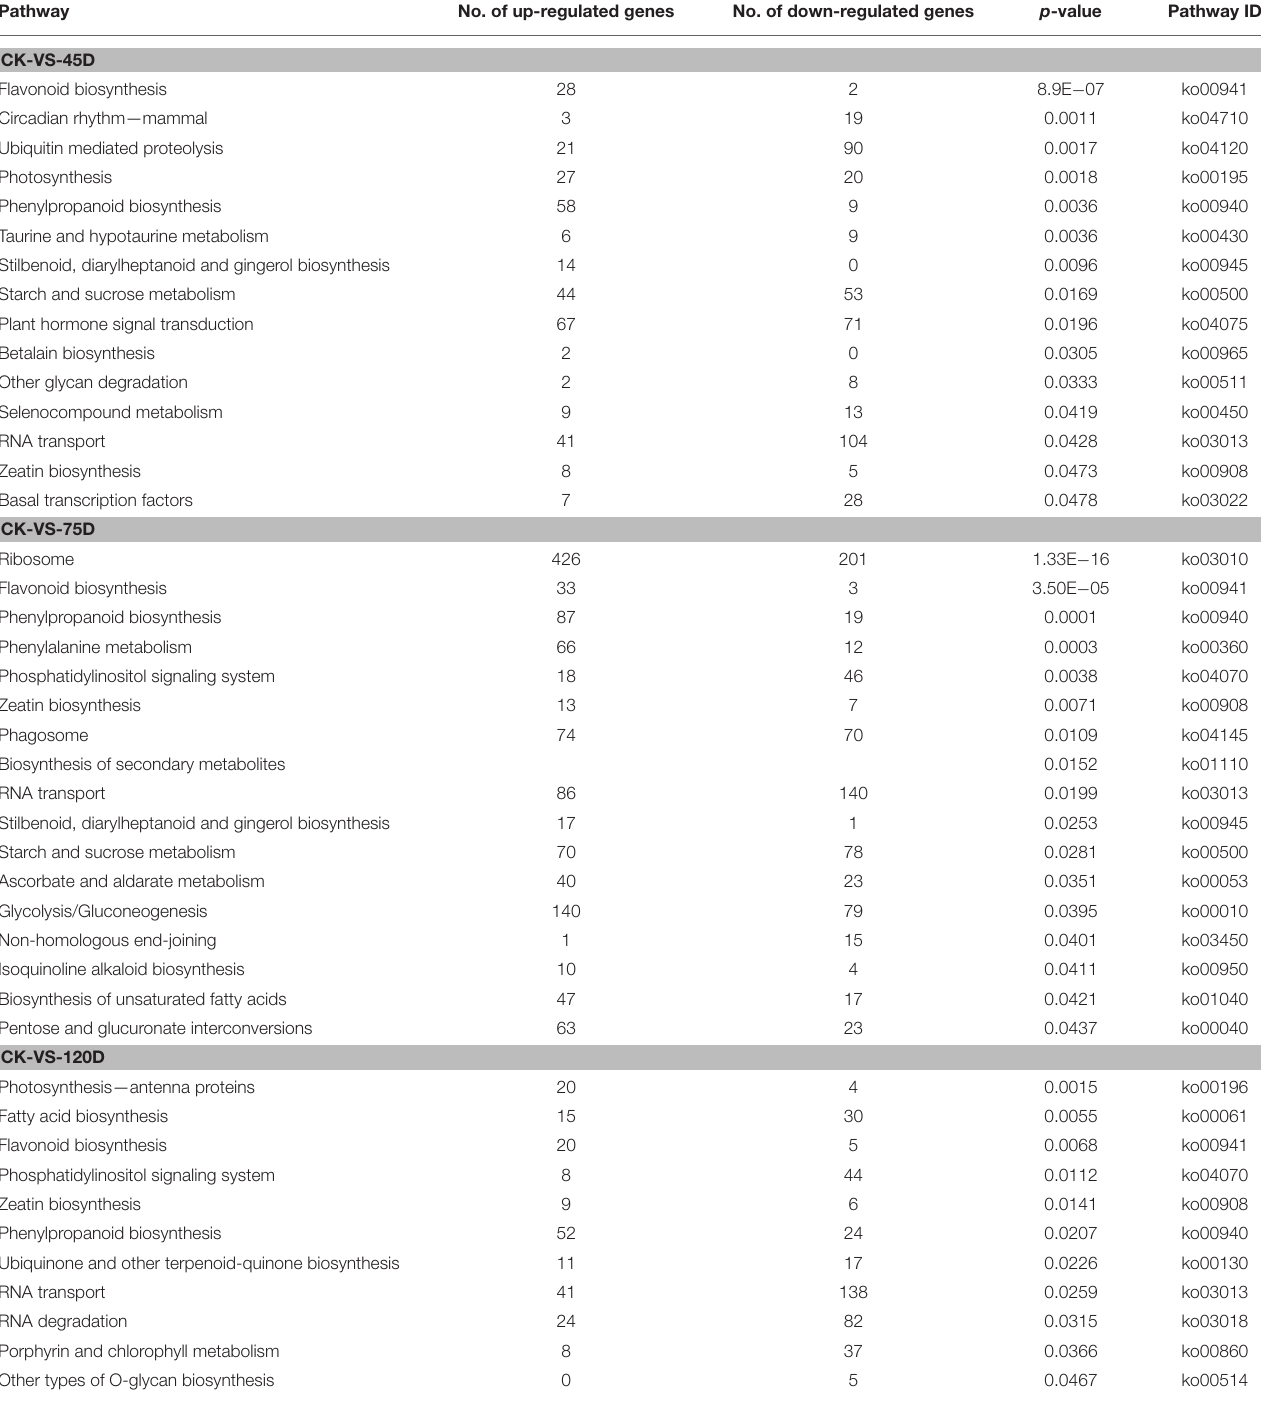
TABLE 2 | Significantly enriched KEGG pathways of DEGs by F. mangiferae infection. Pathway No. of up-regulated genes No. of down-regulated genes p -value Pathway